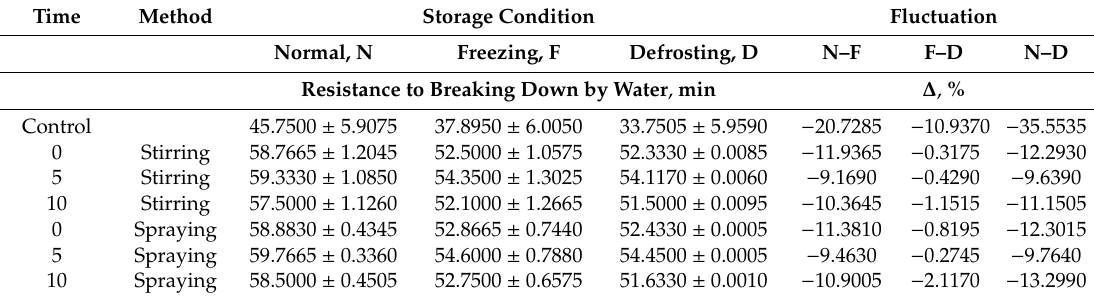
Table 5. Descriptive analysis for the resistance to breaking down by water of fines of non-wood pellets with addition by stirring or spraying of liquid-state food waste subjected to the process of